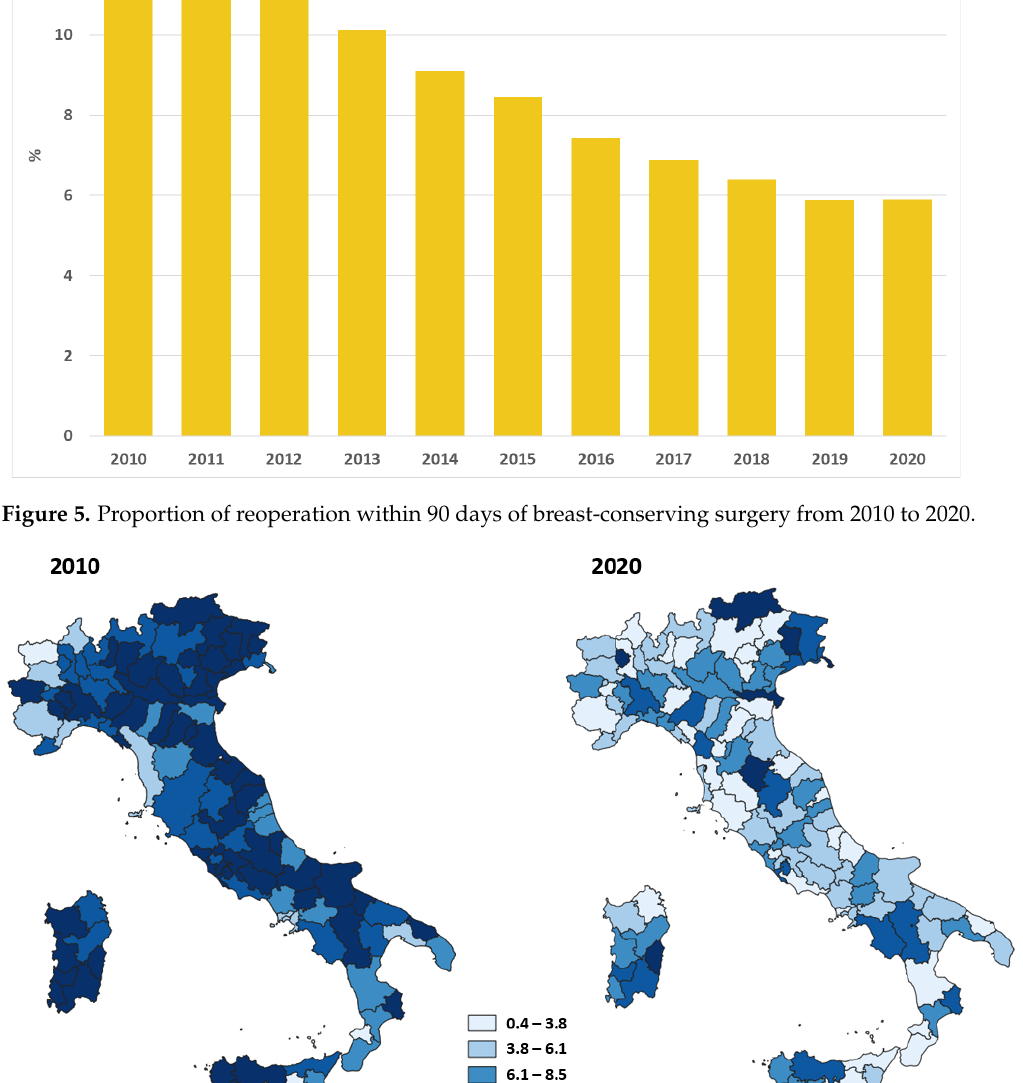
Figure 6. Adjusted proportion of reoperation within 90 days of breast-conserving surgery for Italian area of residence in 2010 and 2020.